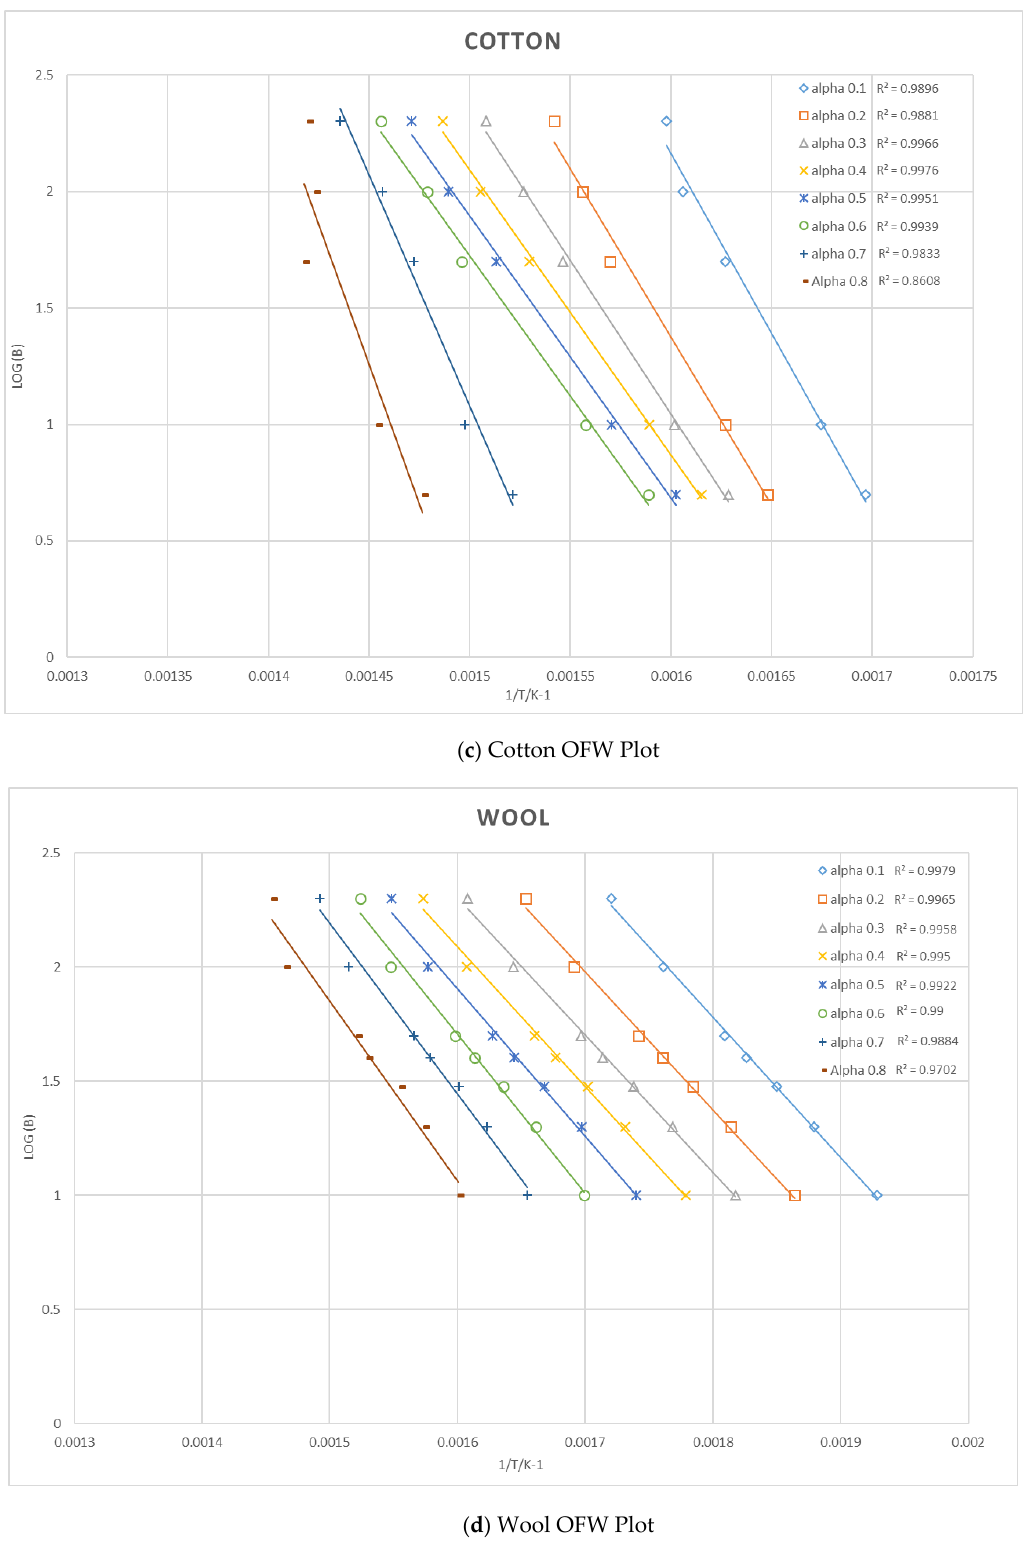
Figure 1. The Ozawa–Flynn–Wall (OFW) method plots for the TGA tests with PMMA, pine, wool and cotton.